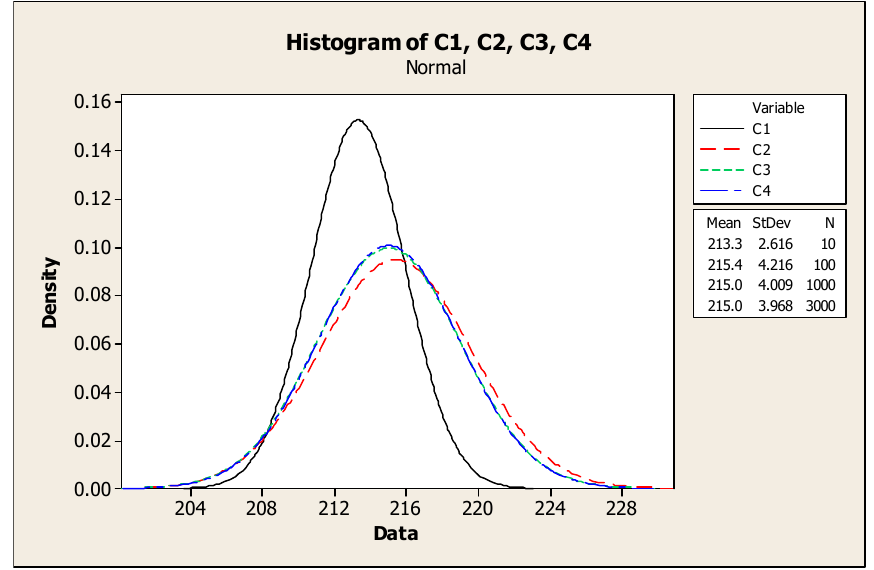
Figure 6. Minitab results for scenario generations.